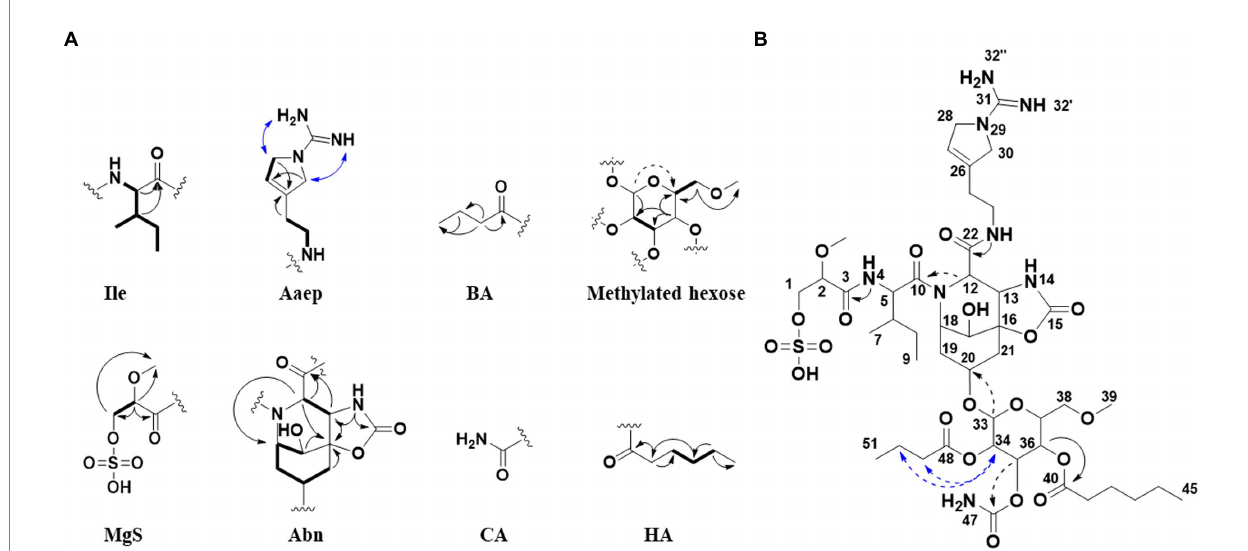
FIGURE 3 (A) Selected 2D NMR correlations obtained for substructures of 1 . (B) Key 2D NMR correlations used to connect the substructures and elucidate the complete structure of 1 . HMBC (black arrows), COSY (bold), ROESY (blue arrows). Weak correlations are indicated with dashed arrows. Ile, isoleucine; Aaep, 1-amidino-3-(2-aminoethyl)-3-pyrroline; BA, butyric acid; MgS, 2-O-methylglyceric acid 3-O-sulfate; Abn, azabicyclononane; CA, carbamic acid; HA, hexanoic